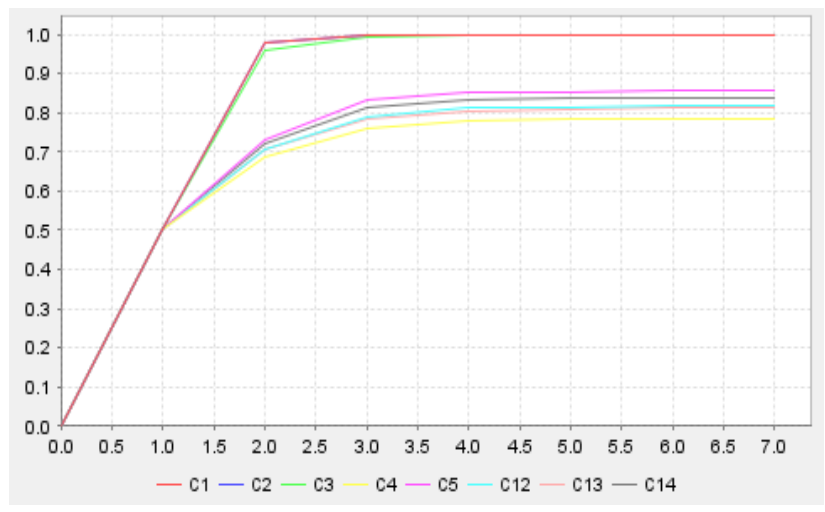
Fig. 8. FCM of P&H inference process.